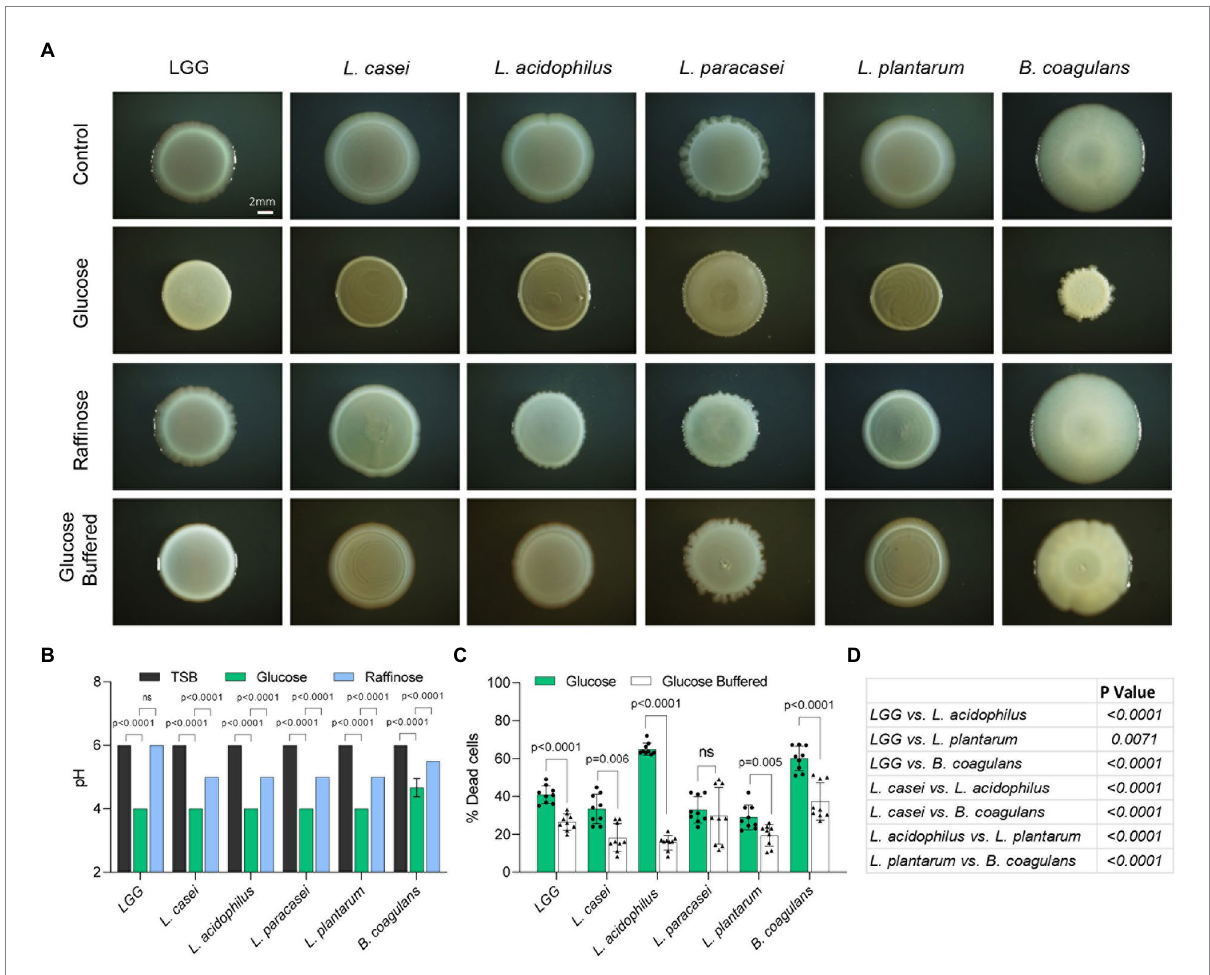
FIGURE 4 Self-imposed acid stress has a role in the formation of structured microbial colonies. (A) Shown are the indicated biofilm colonies grown on TSB medium (control), TSB medium supplemented with glucose and raffinose (1% W/V), and TSB medium supplemented with glucose (1% W/V) + buffer. Biofilms were grown at 37 ° C in a CO 2 enriched environment. Biofilm colonies were imaged at 72 h post inoculation. Scale bar = 2 mm. (B) Measurement of pH of the indicated species shown in A. Statistical analysis was performed using two-way ANOVA followed by